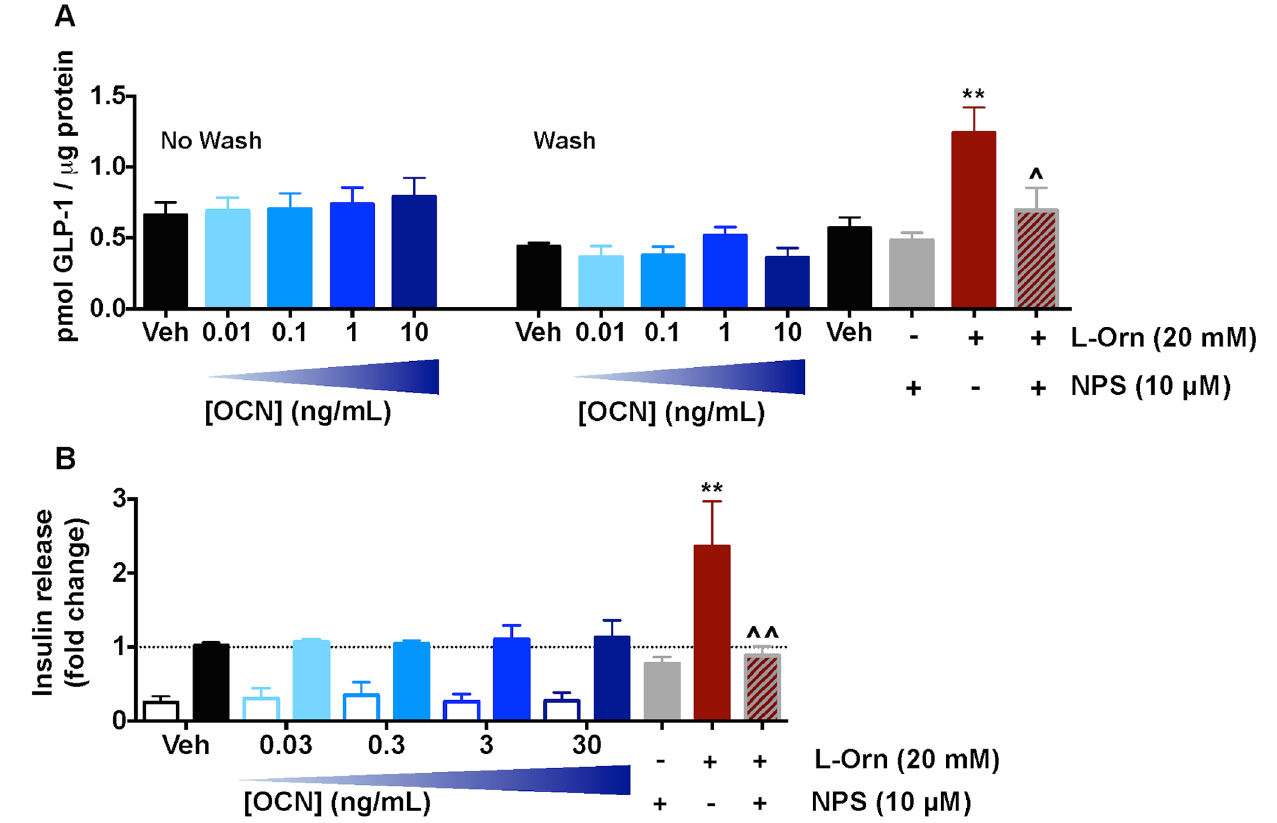
Fig 6. GPRC6A signalling in endogenously expressing cells. (A) L-ornithine (20 mM) significantly increases GLP-1 release from GLUTag cells ( ** P < 0.01 vs Vehicle, one-way ANOVA followed by Sidak ’ s multiple comparisons test). This effect is significantly reversed by NPS-2143 (^ P < 0.05 vs. L- ornithine alone). Human synthetic OCN (0.01 – 10 ng/ml) did not significantly modulate GLP-1 release with or without cell washing. (B) High [glucose] significantly enhanced insulin secretion by MIN6 cells ( P < 0.0001, two-way ANOVA). L-ornithine (20 mM), but not mouse synthetic OCN (acid form; 0.03 – 100 ng/mL), significantly increased glucose-sensitive insulin secretion ( ** P < 0.01 vs. Vehicle, one-way ANOVA for high [glucose] group followed by Sidak ’ s multiple comparison test. ^^ P < 0.01 vs. L-ornithine alone). Open bars, no glucose; filled bars, 16.7mM glucose. Data normalised to Insulin release in the presence of 16.7mM glucose.